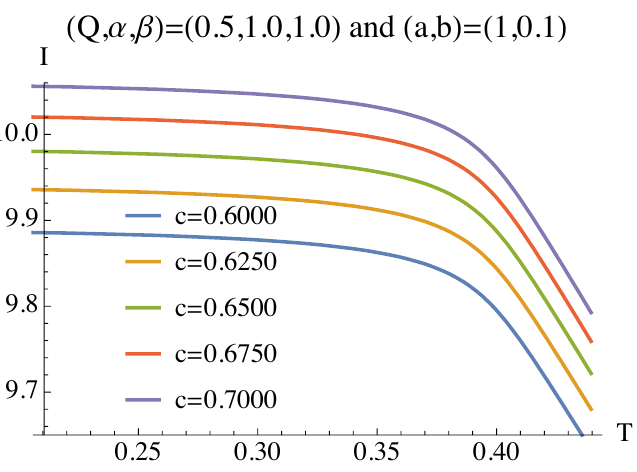
Figure 10 . The T vs. I in the case without thermal phase